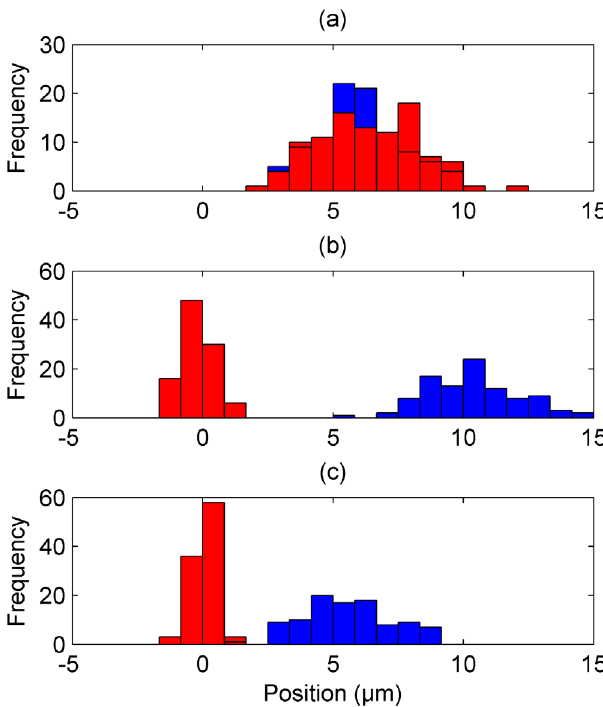
FIG. 16. Distribution of beam positions measured at P3 with feedback off (blue) and on (red) for (a) the first, (b) the second, and (c) the third bunch in each train.